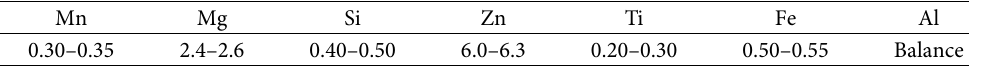
Table 1: Compositions of Al 6082.